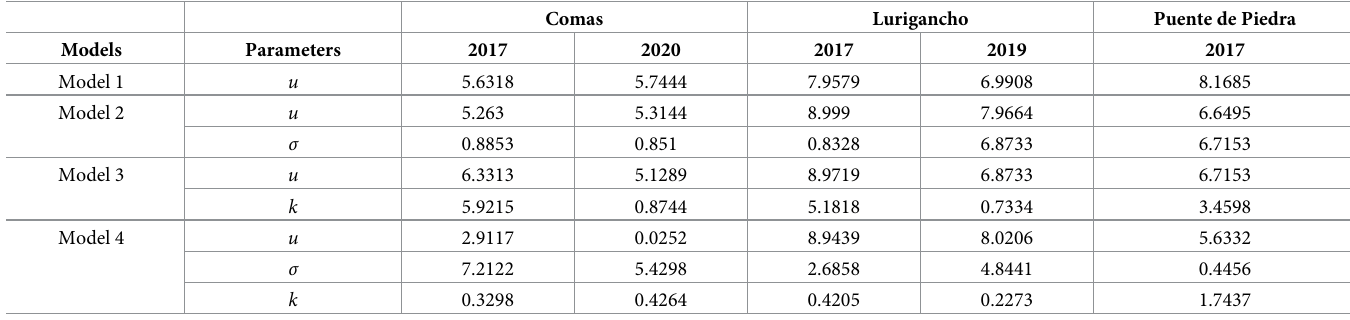
Table 5. Model parameters by